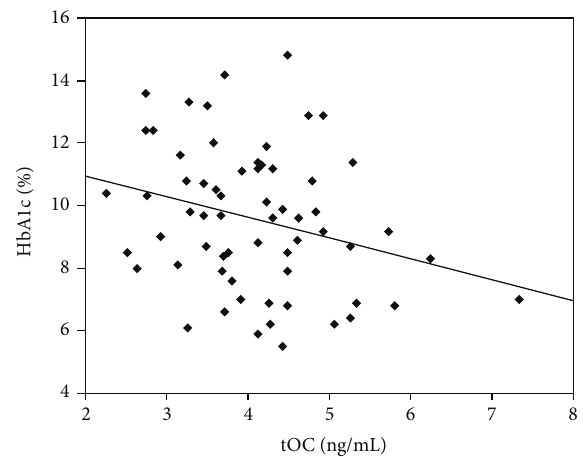
Figure1:NegativecorrelationbetweentOCandHbA1c( 𝑟 = −0.277 , 𝑃 = 0.028 ).